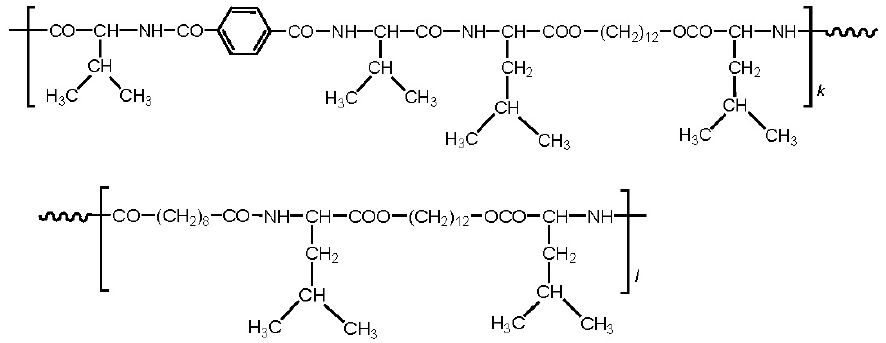
Figure 42. Copolymeric AABBP on the basis of azlactone and activated sebacate and